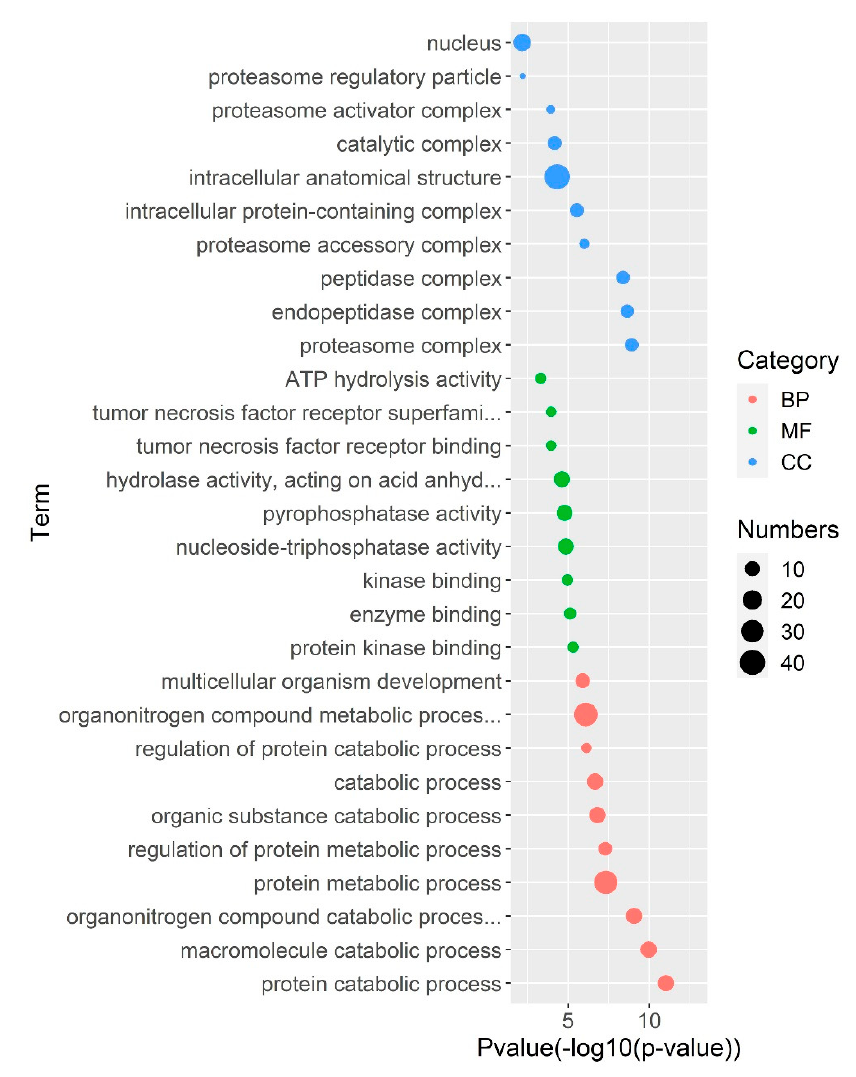
Figure 9. GO analysis of gene regulatory network of CiPSB gene cluster on chromosome segment CI01000319. Note: Red dot BP, green dot MF, and blue dot CC represent three types of GO terms, including biological process, molecular function, and cellular component. The dot size represents the number of genes enriched in the GO term. The ordinate is the term of GO, and the abscissa is the p -value of topGO enrichment analysis, − log10 ( p ).